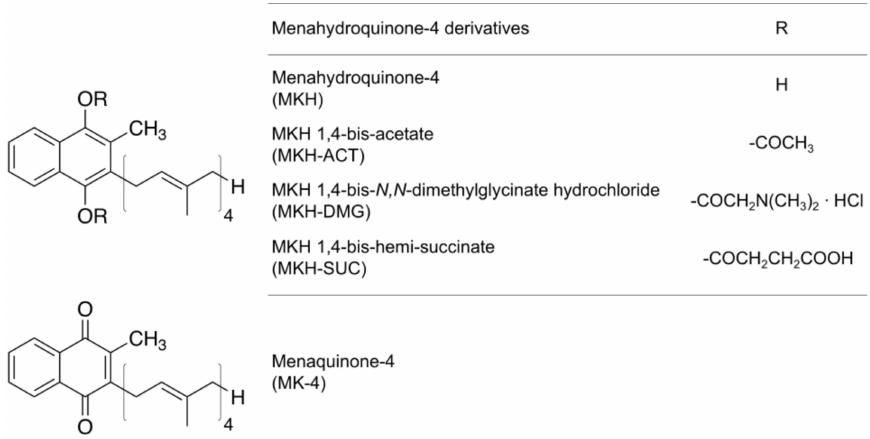
Figure 2. Chemical structures of menahydroquinone-4 (MKH)-ester derivatives and menaquinone-4